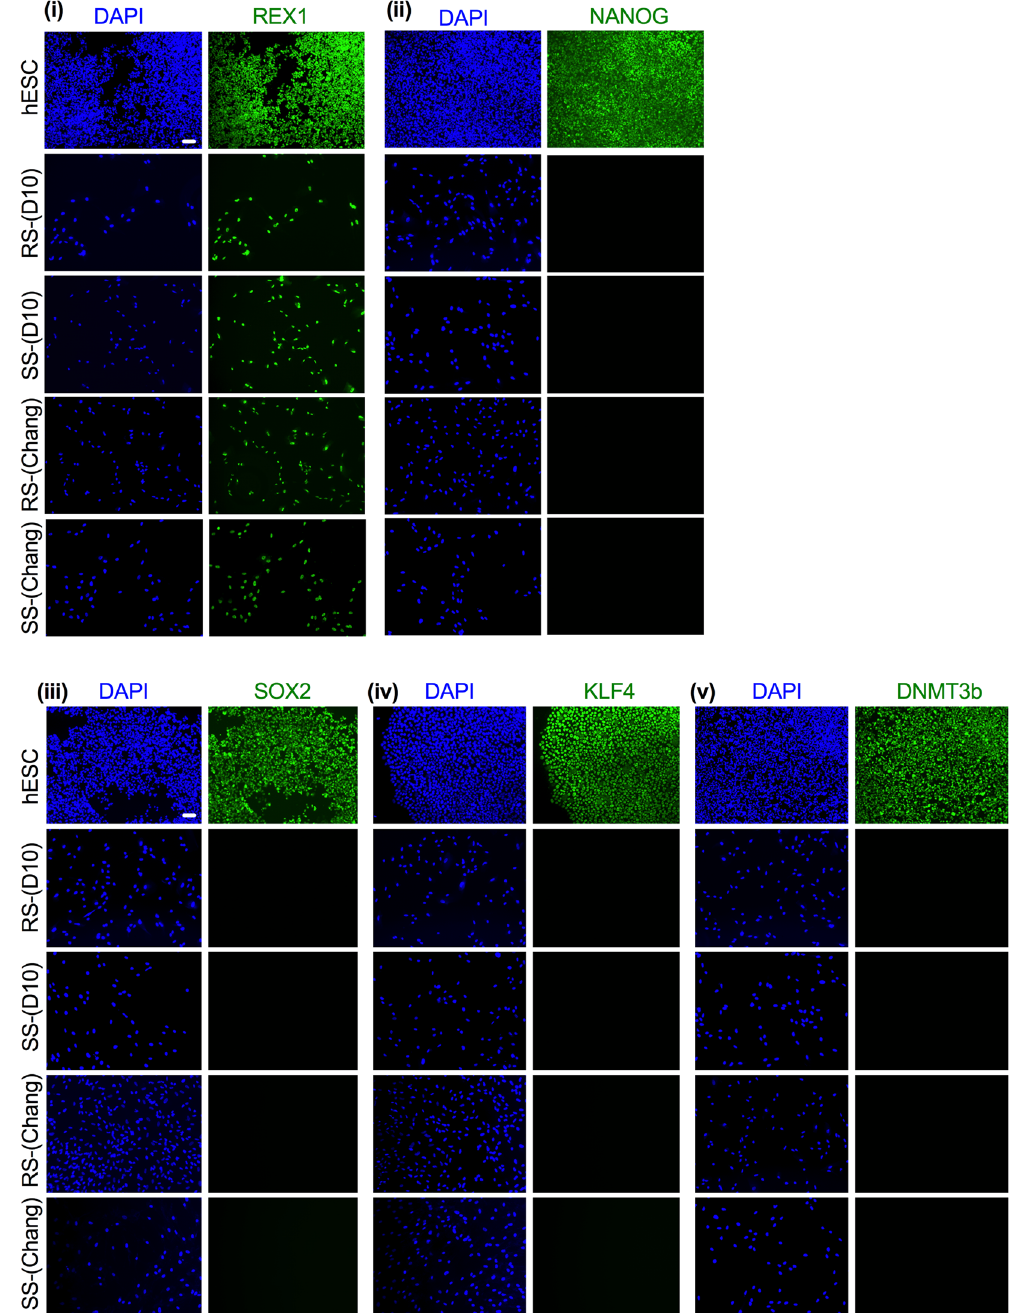
Figure 5. Expression of pluripotency markers in hAFSCs. Immunofluorescence showing expression of the pluripotency associated markers REX1, NANOG, SOX2, KLF4 and DNMT3b. Nuclei were stained with DAPI (blue). Scale bar 50 μ